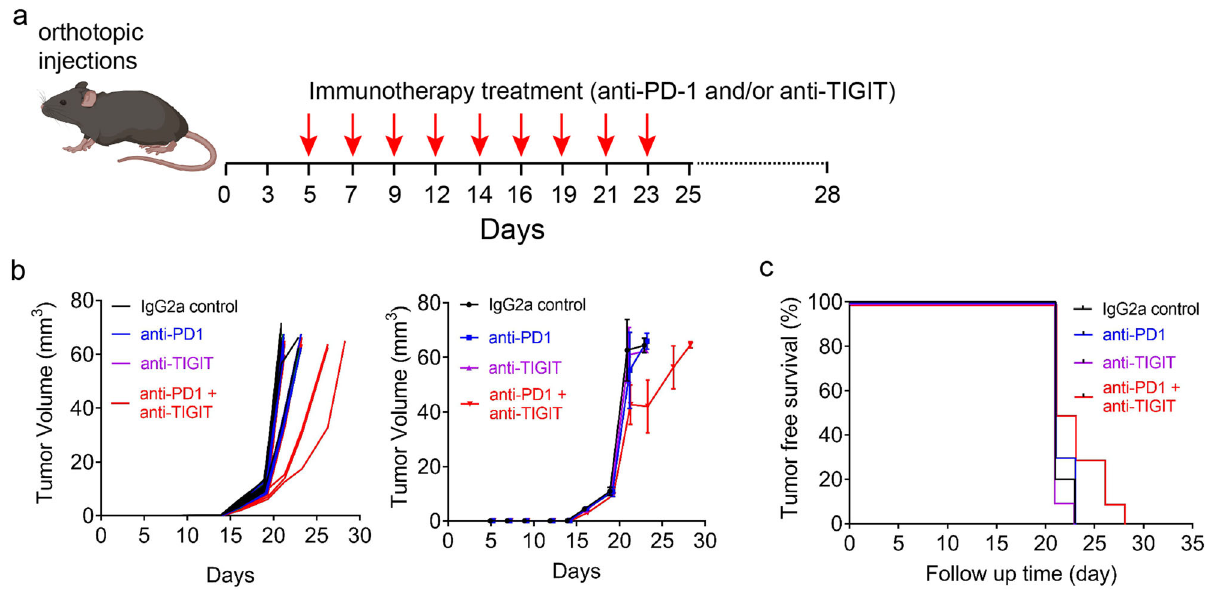
Fig. 3 Immune-excluded mutant p53 – mediated ROC1 tumors do not respond to immune checkpoint inhibition. a Process diagrams of tumor cells orthotopically injected and treated with anti – PD-1 and/or anti-TIGIT antibodies (50,000 cells implanted; n = 10 mice). b ROC1-tumor-bearing mice that received the combination therapy had a slight robust tumor response. Left and right graphs represent individual and mean tumor growth (error bars = standard deviation). c Tumor-free survival with not signi fi cant overall survival (Long-Rank/Mantel – Cox